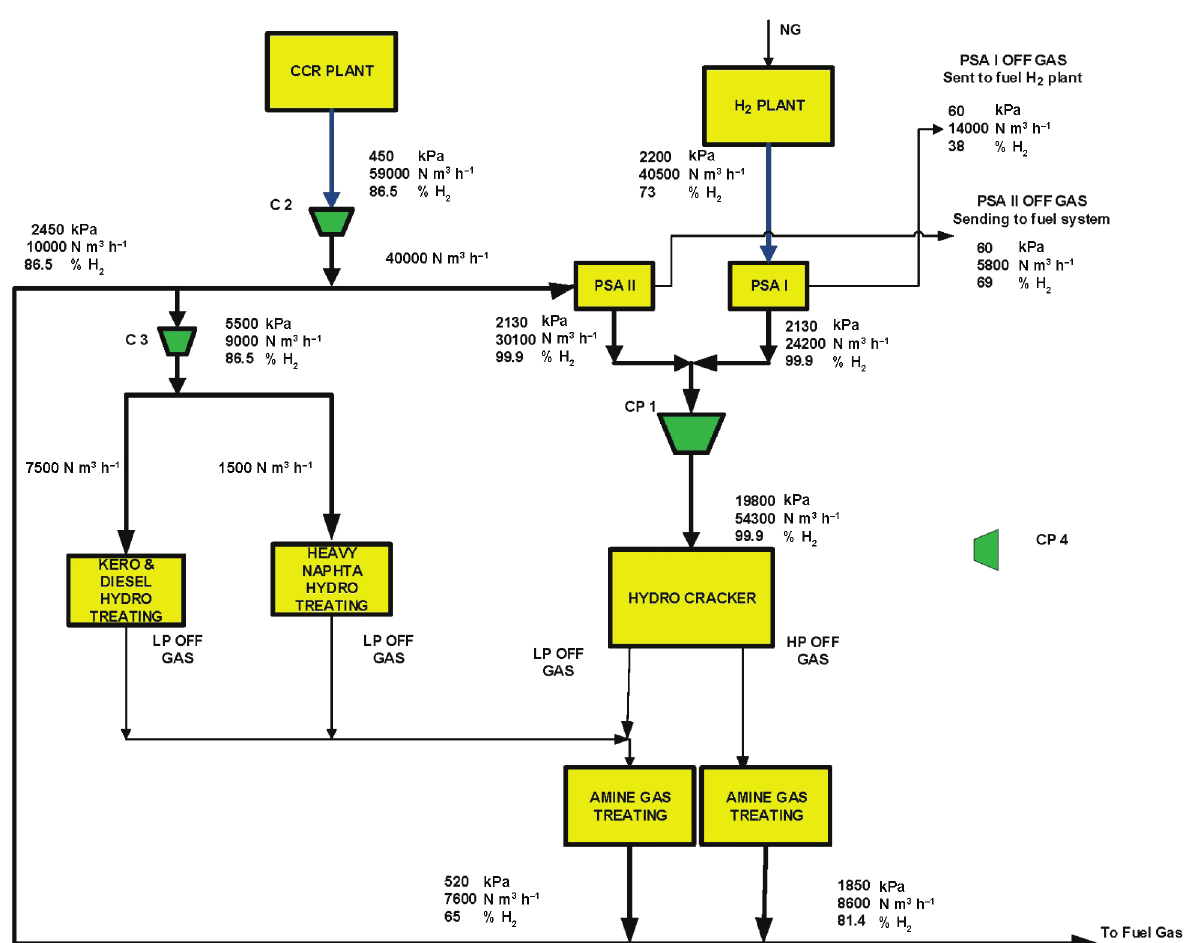
Fig. 2 – Existing refinery hydrogen network 27